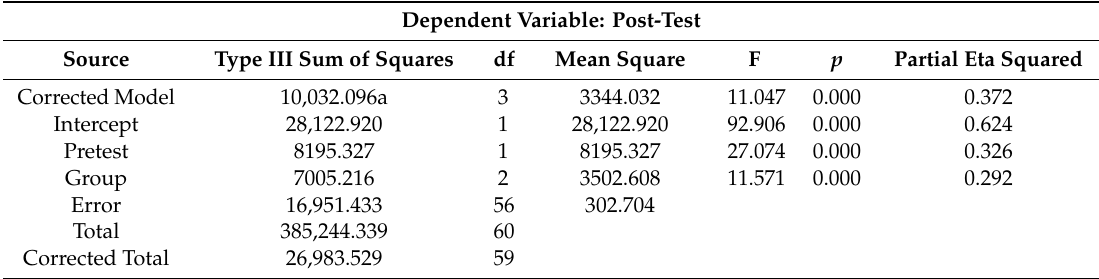
Table 4. Tests of Between-Subjects E ff ects.